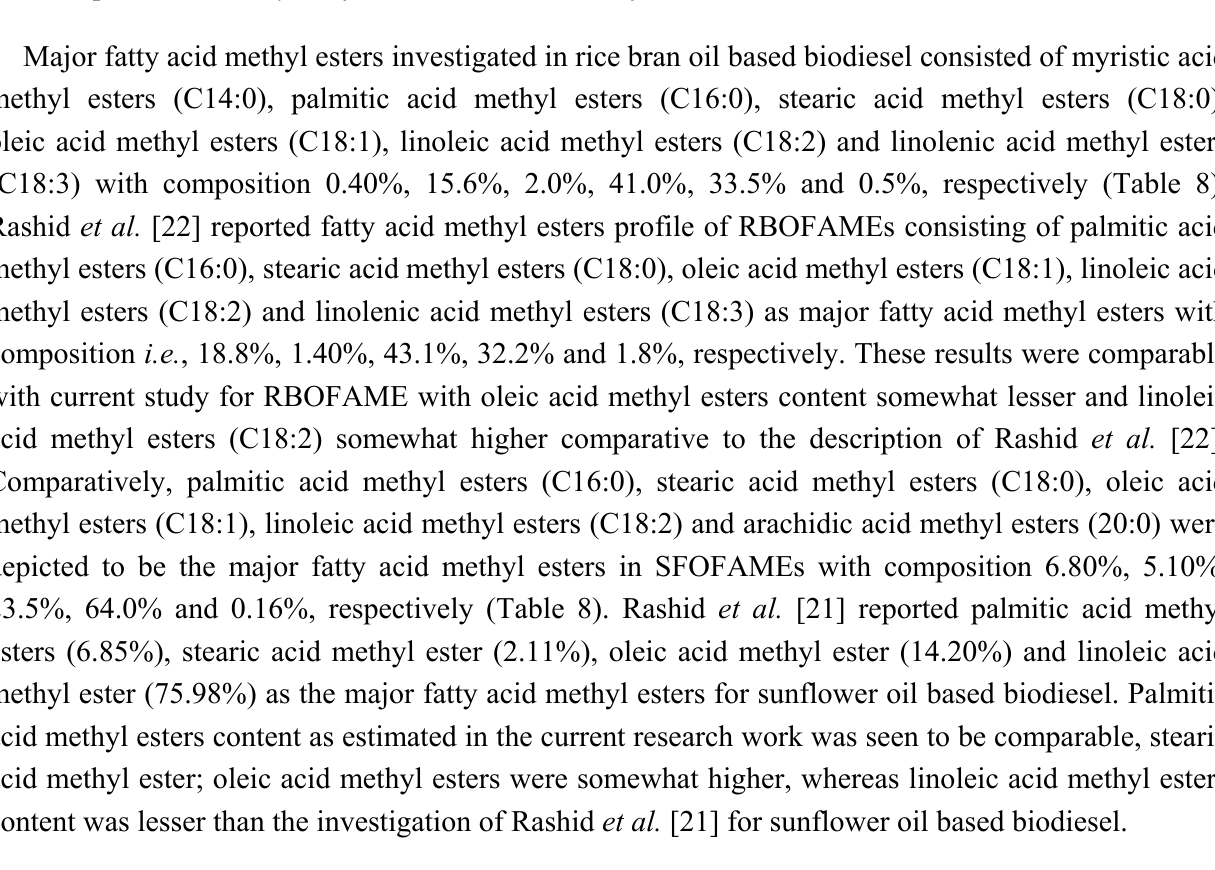
Table 8. Major fatty acid methyl esters of different